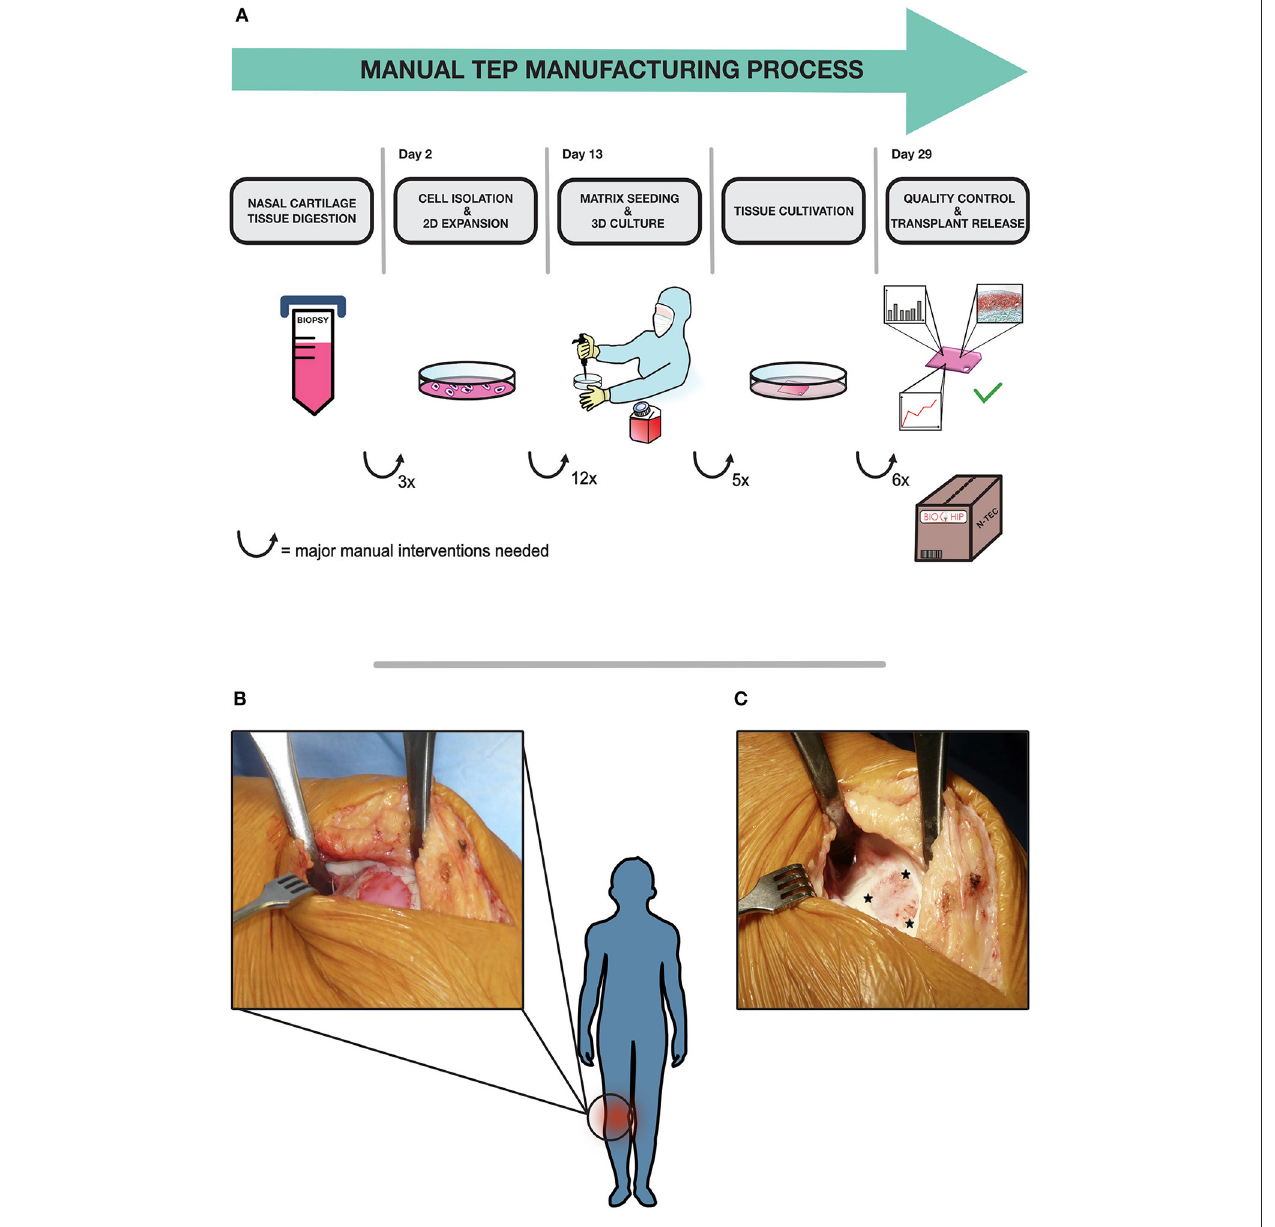
FIGURE 1 | BIO-CHIP manual manufacturing process and surgical procedure. The whole process is graphically depicted in (A) . An autologous cartilage biopsy is taken via outpatient surgery in a clinical site from the patients’ nasal septum according to SOP. The biopsy is shipped to the manufacturing site, where the tissue is digested and the cartilage cells are isolated and expanded in-vitro. In the next step, cells are manually seeded on a collagen membrane in a certified cleanroom facility. Various parameters are monitored continuously throughout tissue cultivation. After 2 weeks of static tissue culture, final quality testing is conducted. The amount of extracellular matrix proteins is evaluated using histological grading by modified Bern score, also cell viability and transplant stability are assessed. When all defined release criteria are met, the N-TEC is packed and sent back to the clinic to be implanted into defect site in a surgical procedure (B) . The patch is secured by surrounding absorbable sutures during the surgical procedure. The initial focal cartilage defect in the knee is depicted in (C) , asterisks indicate the defect site where the N-TEC is